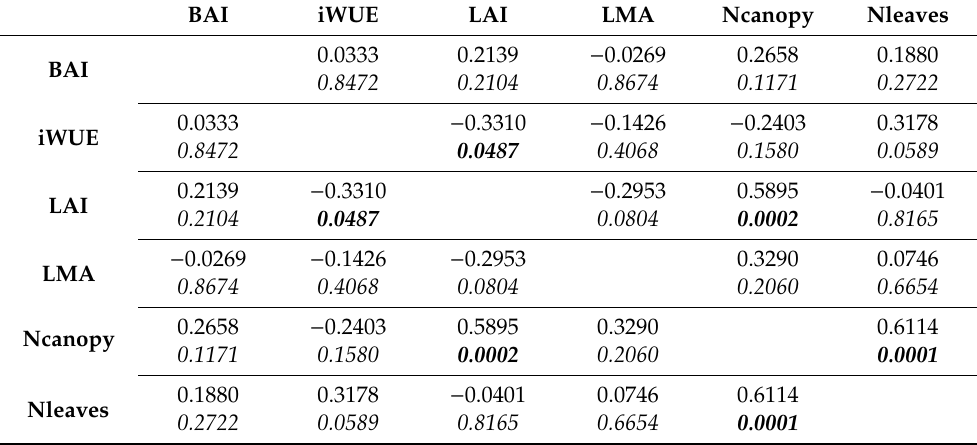
Table 1. Correlation matrix for basal area increment (BAI), intrinsic water use e ffi ciency (iWUE),